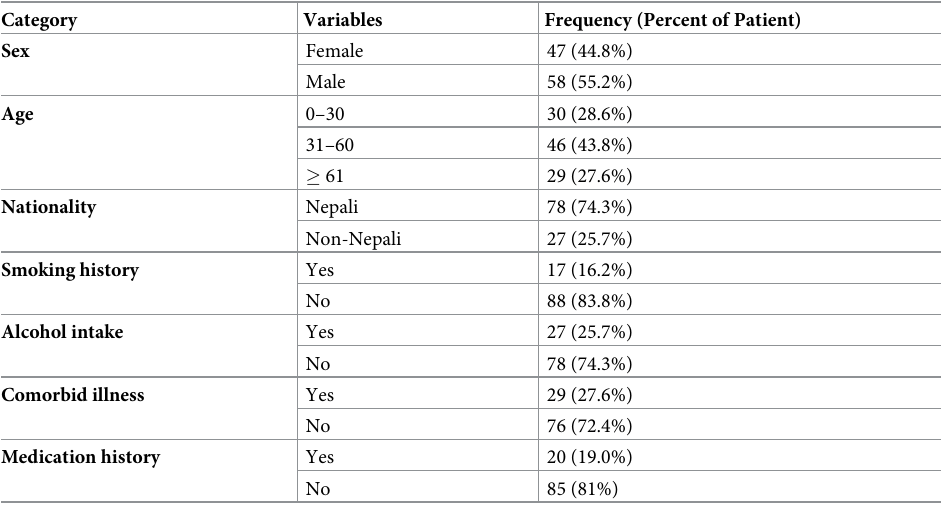
history: patient is taking any medication for comorbidities or illness.